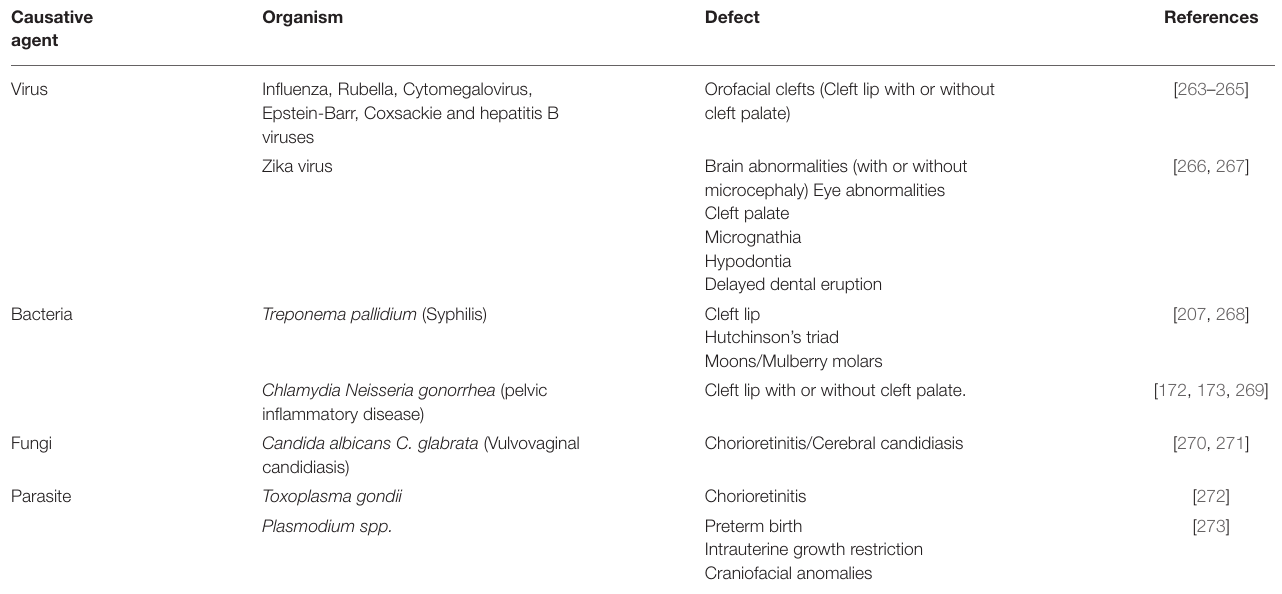
TABLE 2 | Key organisms associated with congenital craniofacial defects in the newborn. Causative